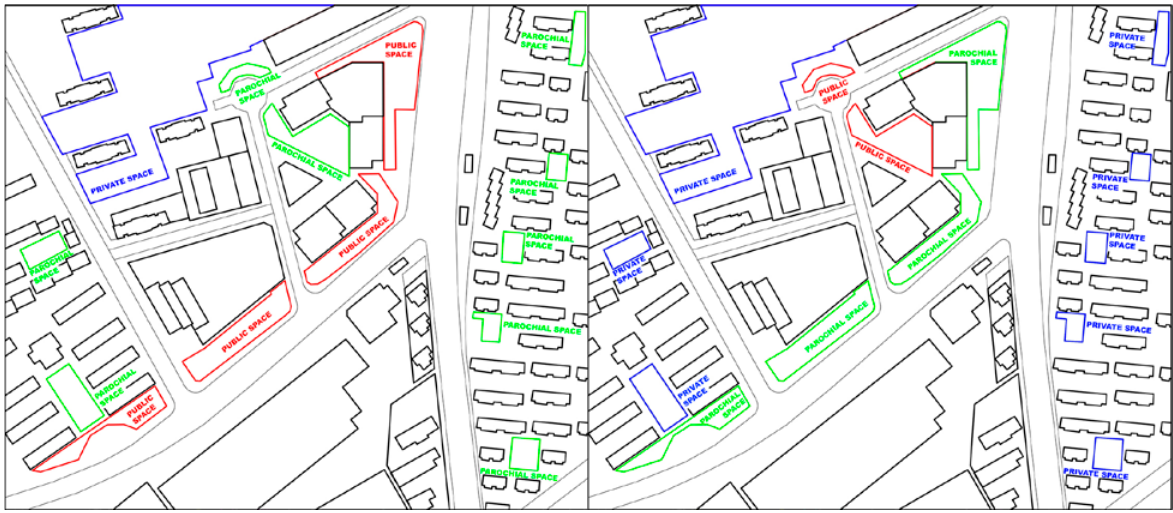
district.fig. 3. left: assessment and classification of public space based on masterplan review; right: assessment and classification of public space following site